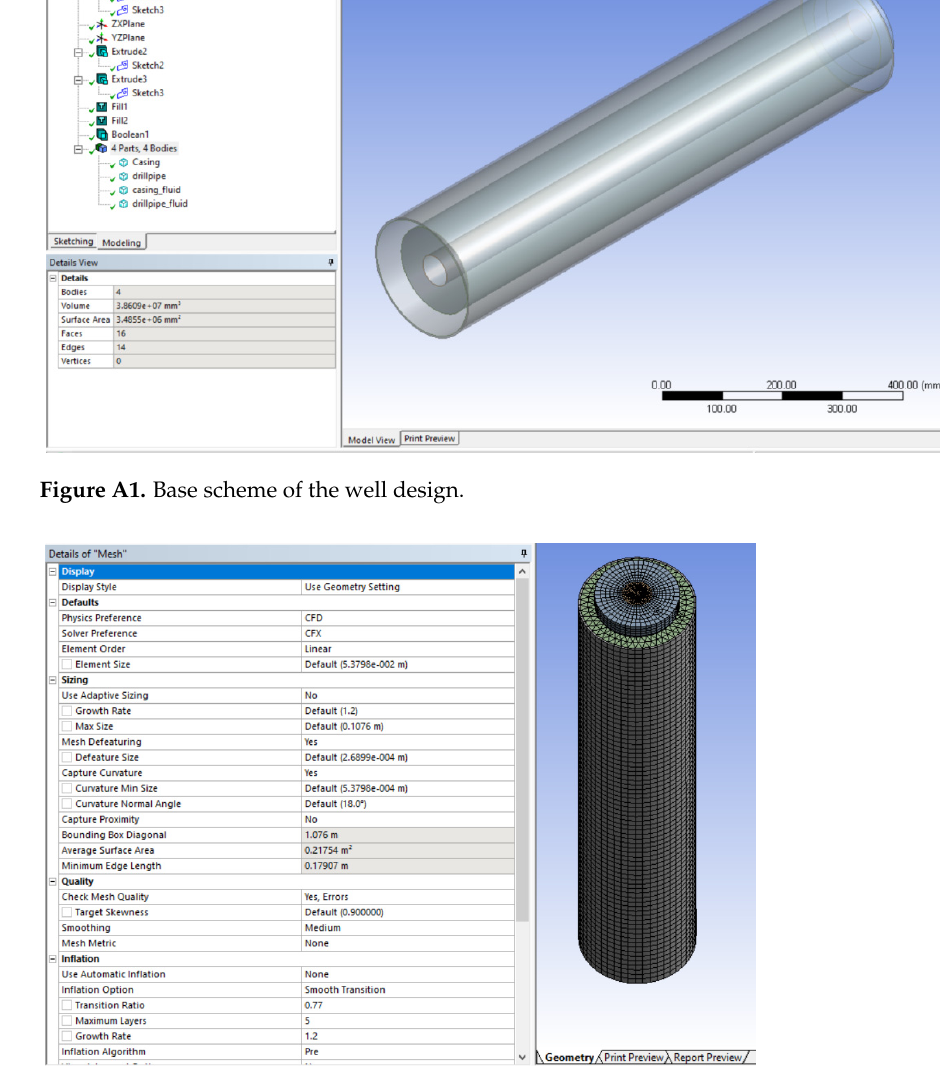
Figure A2. Characteristics of the mesh used in the modeling .